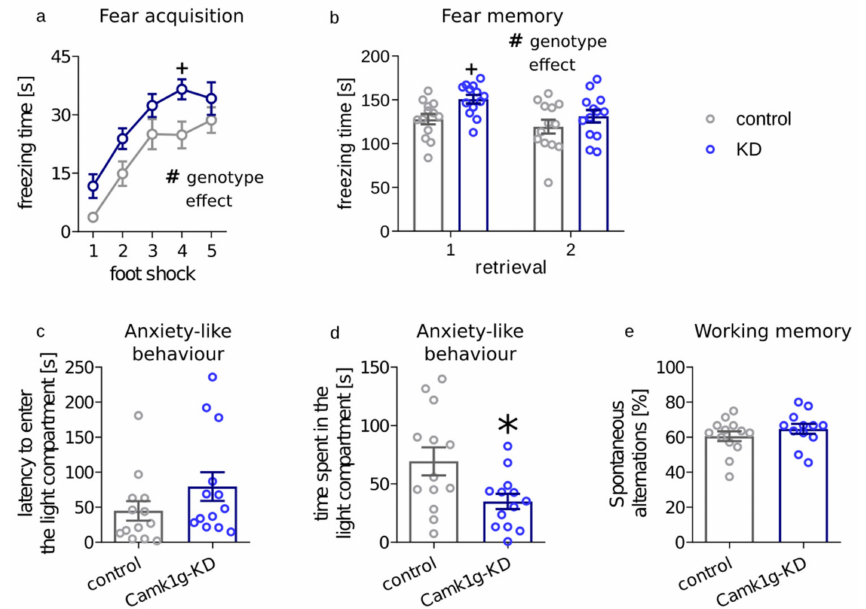
Figure 2. The behavioral effects of Camk1g knockdown in CeA. ( a ) Plot summarizing the freezing time of control (gray dots) and CeA-Camk1g-KD mice (blue dots) upon exposure to consecutive electric foot shocks. ( b ) Freezing behavior upon exposure to the cue during retrieval sessions performed at indicated sessions after the training. ( c ) Latency to enter the light compartment of the light-dark box ( d ) Total time spent in the illuminated compartment of the LD box ( e ) Spontaneous alterations measured in Y maze test. Mean ± SEM, * p < 0.05 for genotype effect in t test, + p < 0.05 for genotype effect in Bonferroni post hoc test, # p < 0.05 for genotype effect in two-way ANOVA. We then measured conditioned fear expression in two subsequent retrieval